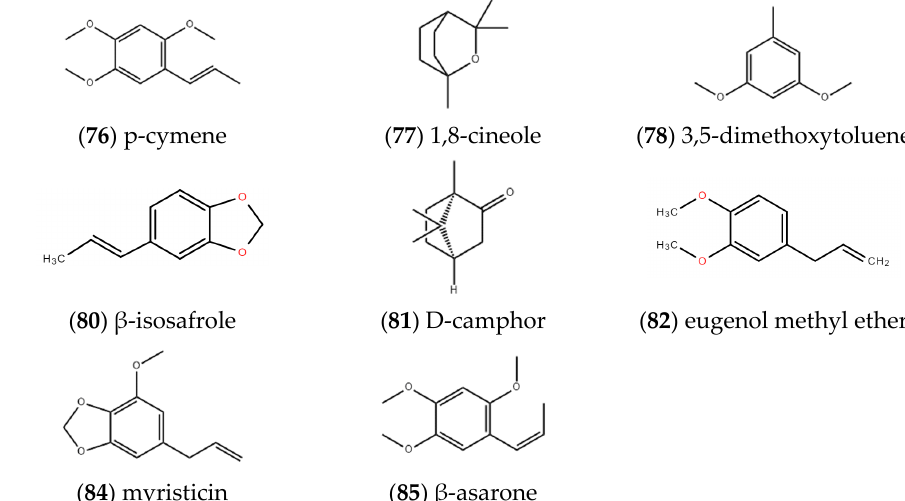
Figure 7. Structures of other compounds in volatile oil isolated from ST .